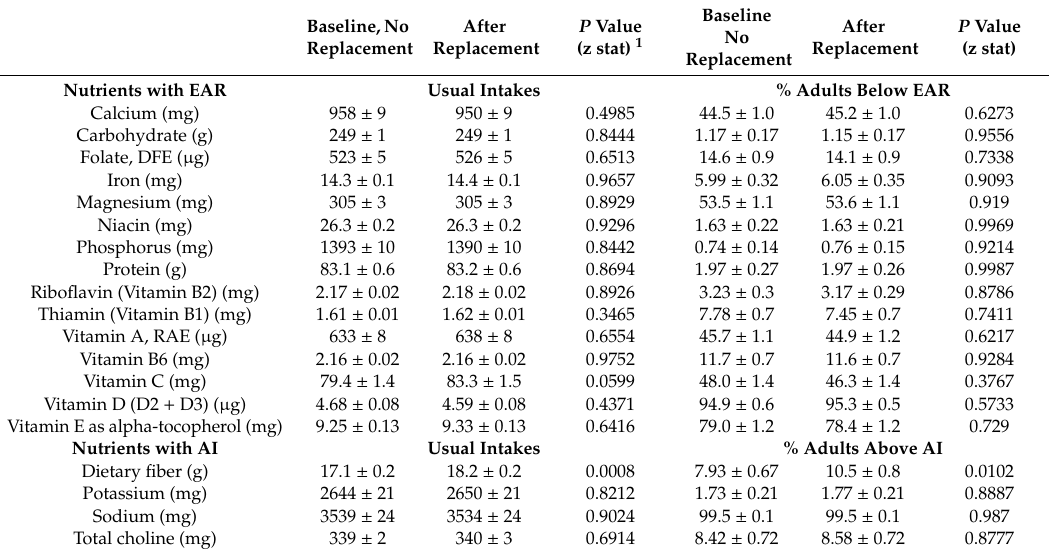
Table 5. E ff ect of isocaloric replacement of 100% fruit juice with whole fruit equivalents on usual intakes of nutrients and population adequacy for adult (19 + years of age, n = 10,112)—NHANES 2013–2016